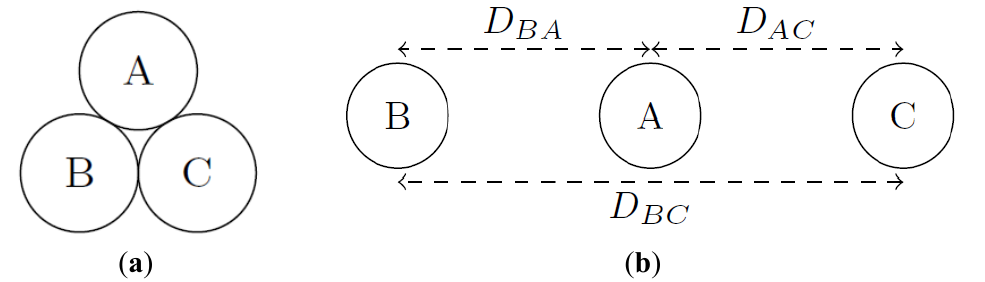
Figure 4. Original ( a ) and ( b ) modified cable layouts. ( a ) Real life three-core tight triangle cable layout implemented in PSCAD; ( b ) Modified flat cable layout implemented in